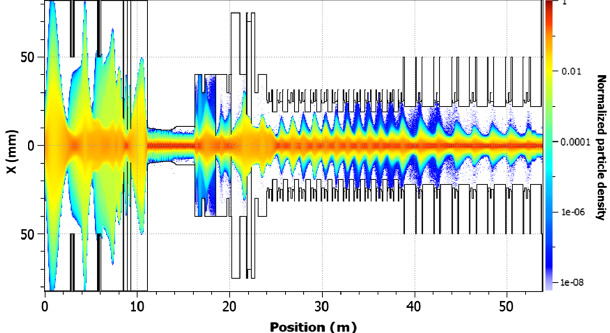
FIG. 17. Horizontal particle density of a 5 mA 2 H þ beam for the reference simulation with 2 . 5 × 10 9 particles.